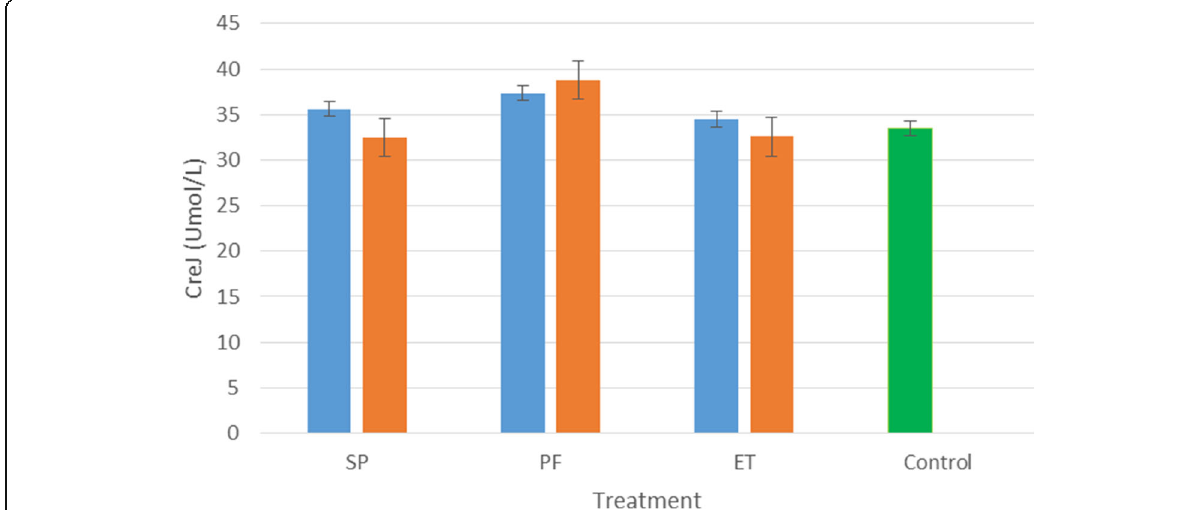
Fig. 2 Effect of the aqueous plant extracts on the levels of creatinine in the kidney